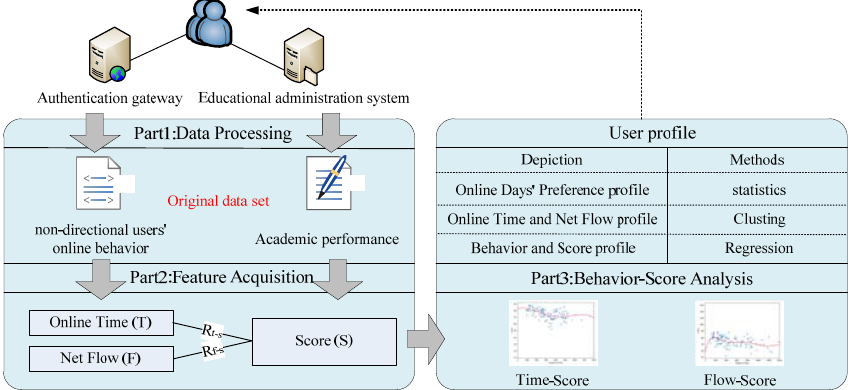
Figure 1. User profile based structure of OBSC model.